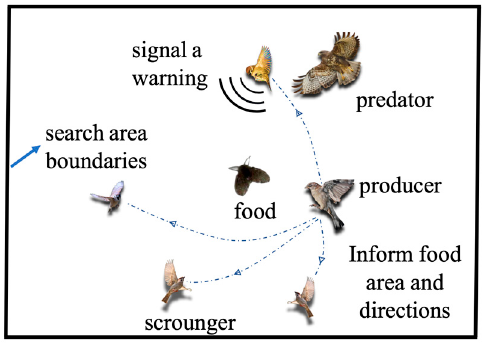
Figure 5. Schematic diagram of the sparrow search